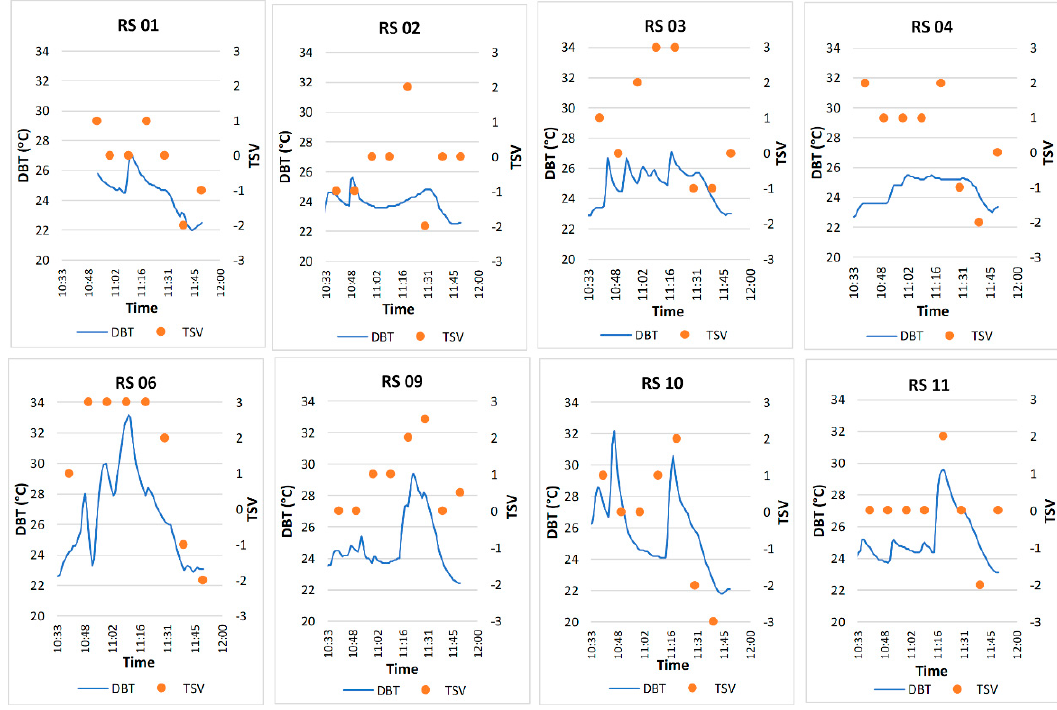
Figure 16. Profile of measured DBT and Thermal Sensation Vote (TSV) (source: Bluetooth sensors and real-time questionnaire answers from the students).